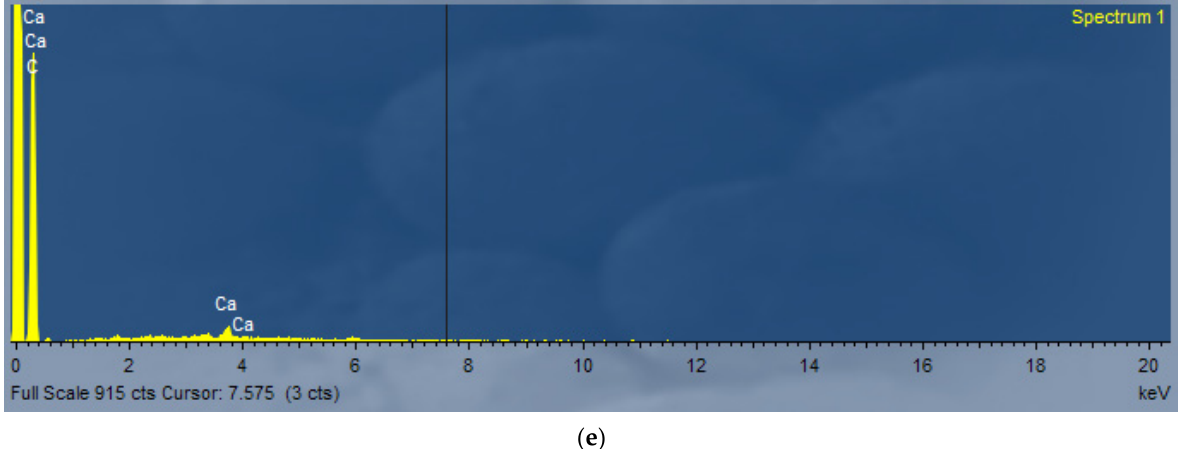
Figure 2. ( a ) SEM image of the BCS_650; EDS mapping results showing the distribution of ( b ) C, ( c ) Ca and ( d ) C (green spots) and Ca (red spots) elements; ( e ) corresponding EDS spectrum over the as-prepared BCS_650.